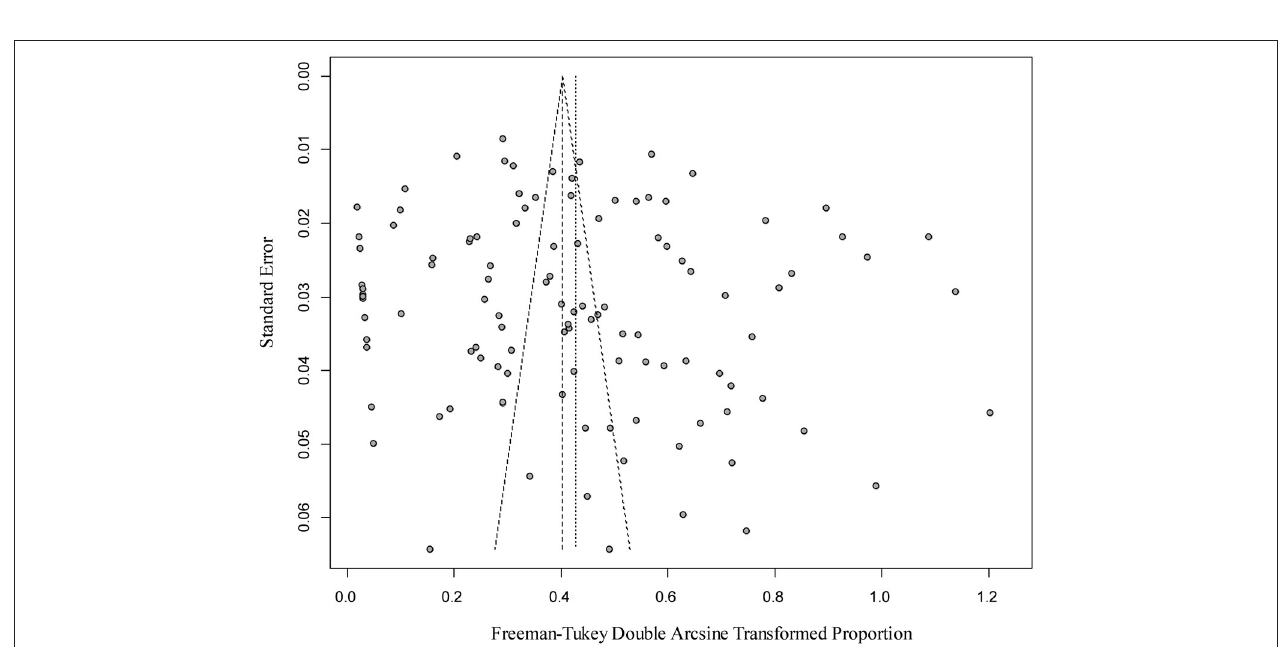
FIGURE 2 | Funnel plot of the analysis publications bias of